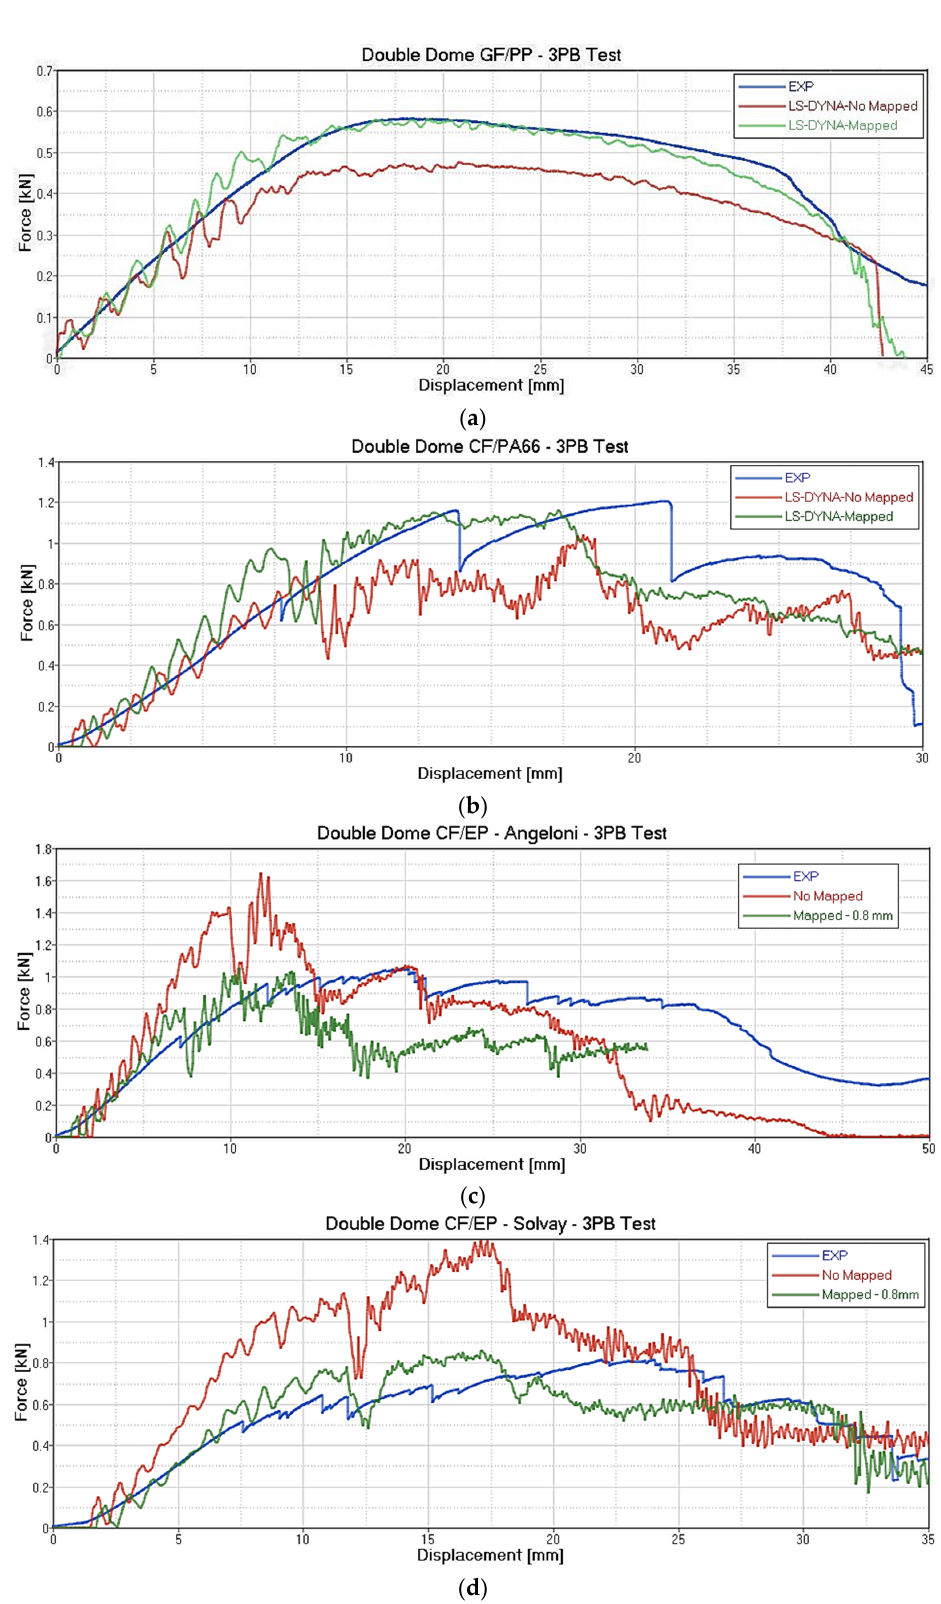
Figure 34. FEA-experimental correlation of the three-point bending test on GF/PP ( a ), CF/PA66 ( b ), CF/EP-Angeloni ( c ), and CF/EP-Solvay Double Dome ( d ).